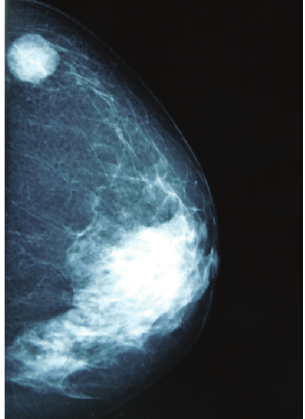
Figure 1: Mammography showing breast tumor.